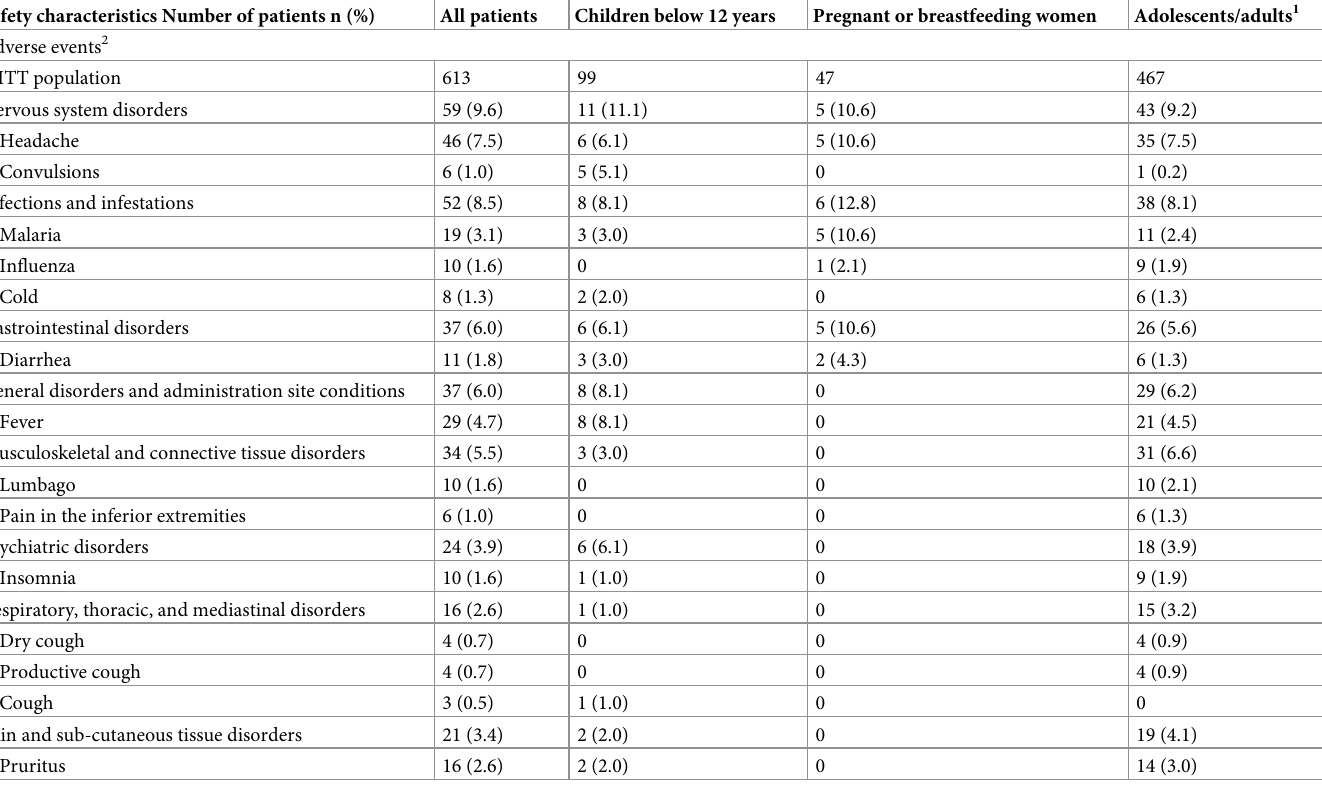
Table 4. Most frequent and relevant adverse events during